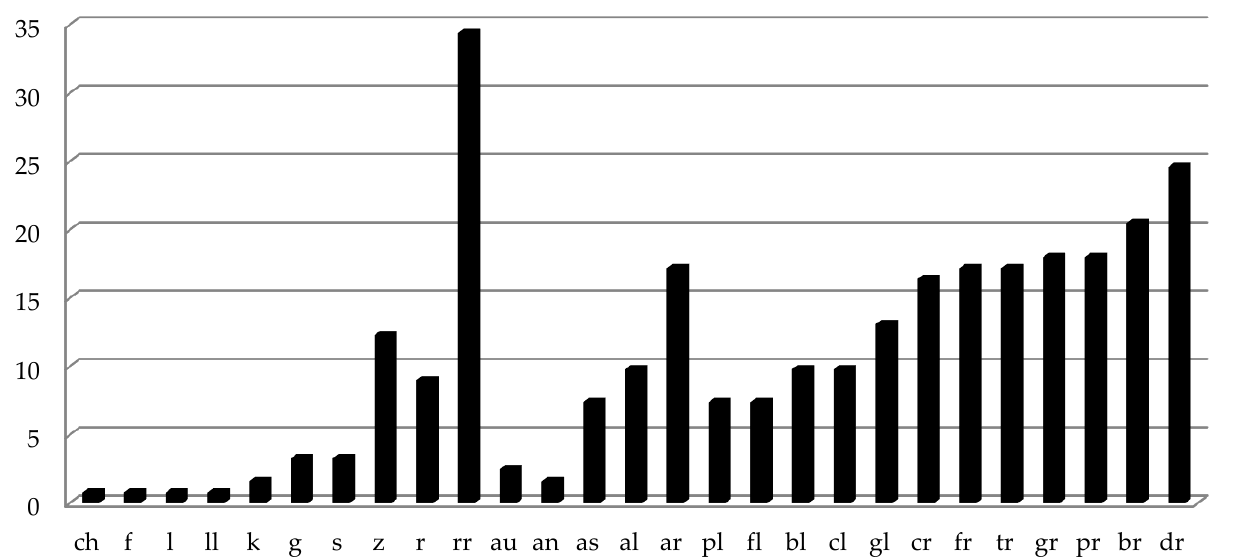
Figure 1. Frequency percentages of non-produced sounds in the pretest assessment. Table 3. Number of non-produced sounds for the experimental and control groups in the pretest and post-test